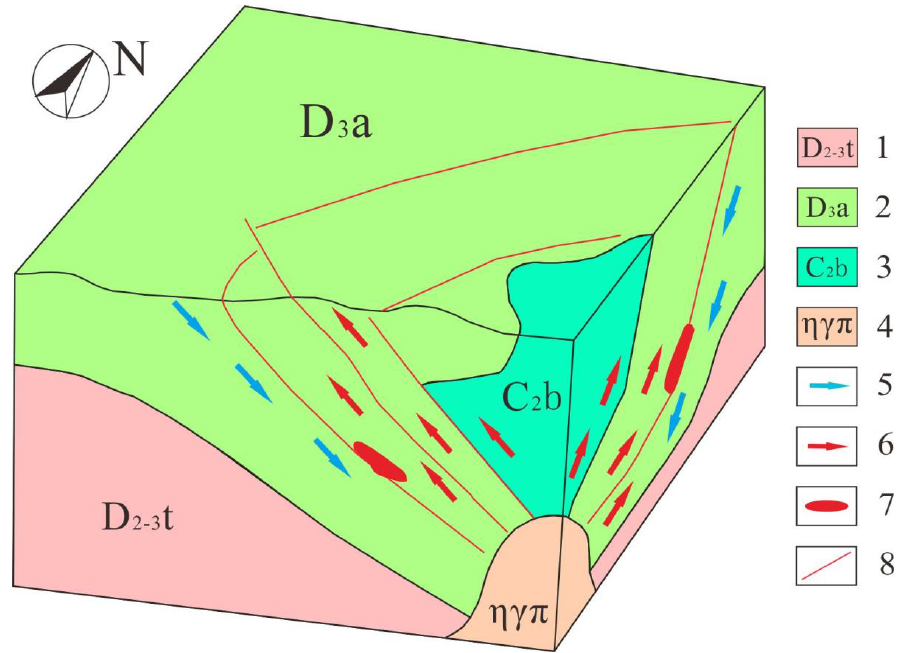
Figure 9. Schematic illustration of the metallogenic model of the Jilinbaolige mining area. Note: 1, Devonian Talbat Formation; 2, Devonian Angelyinwula Formation; 3, Carboniferous Baoligemiao Formation; 4, intrusive rock; 5, atmospheric precipitation; 6, magma; 7, ore body; 8, fault.